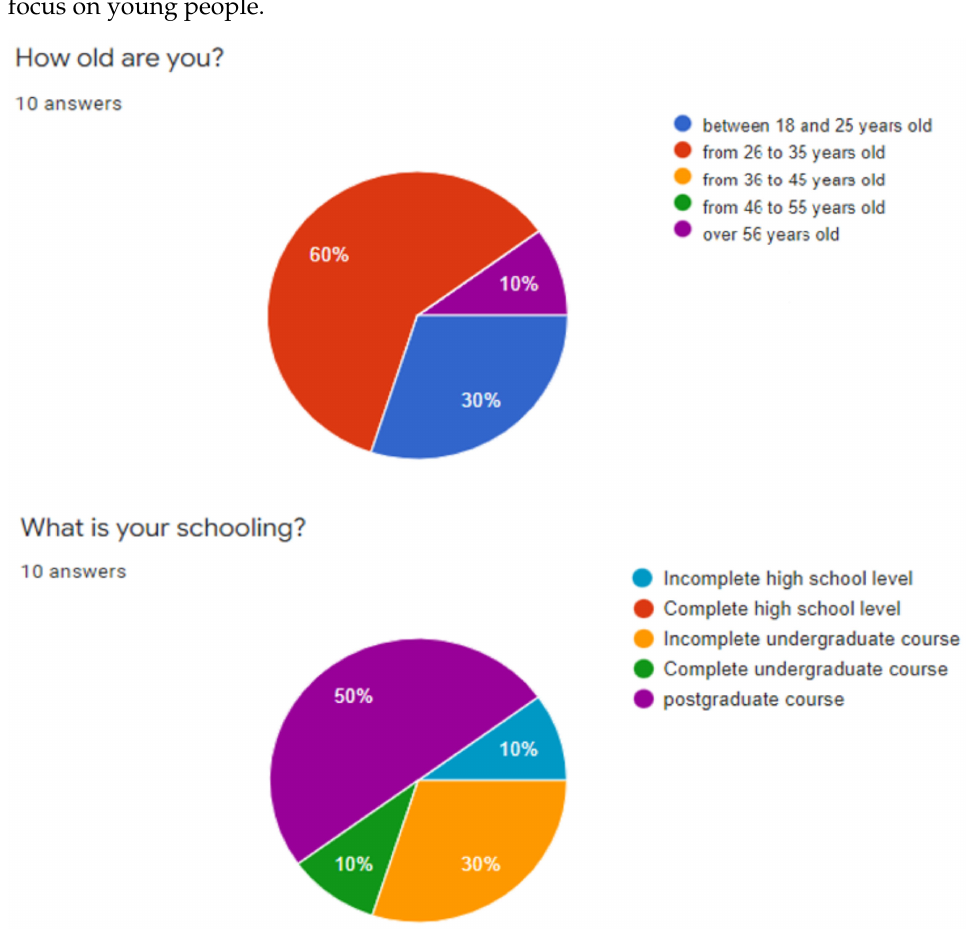
Figure 13. Age range and education level of external